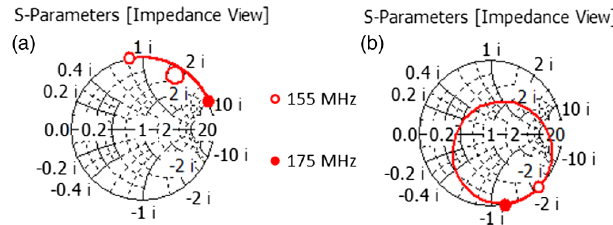
FIG. 10. The SW electric field distributions in fundamental couplers at different reflected phases. (a) presents the electric field with the left short at z ¼ − 30 cm; (b) shows the field with the left short at z ¼ − 76